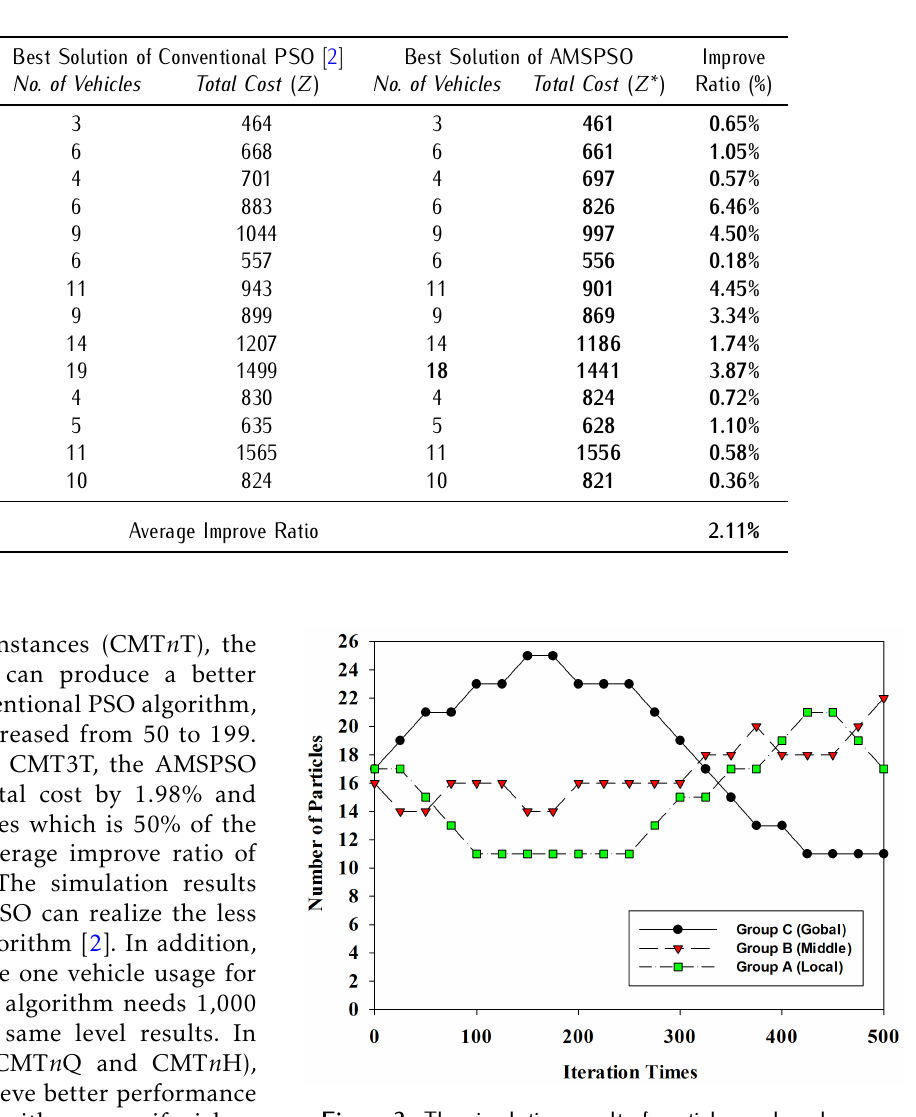
Table 6. Simulation results of CMT n H